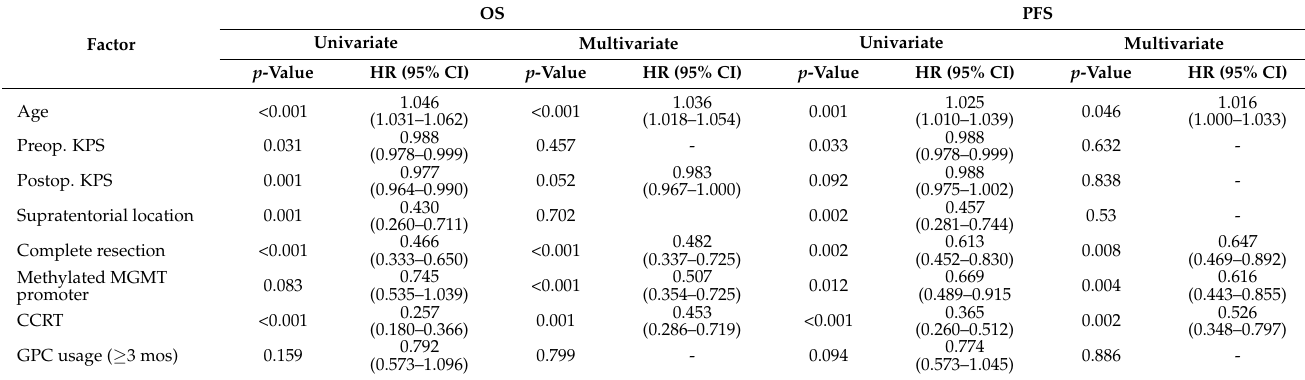
Table 2. Prognostic factors for OS and PFS in the whole series ( n = 187).